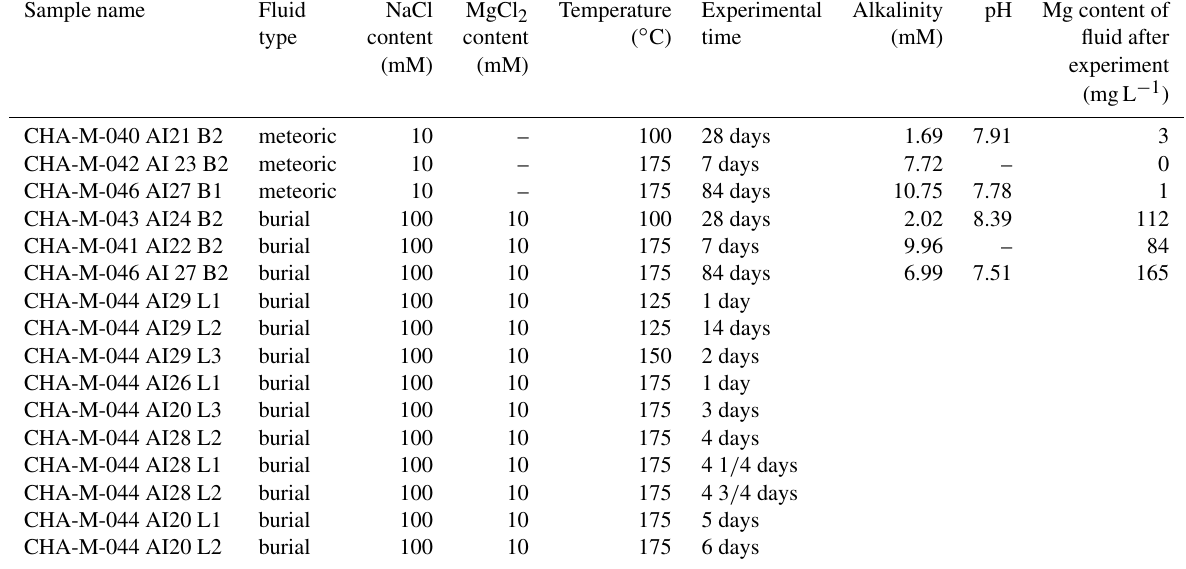
Table 1. Detailed conditions used in hydrothermal alteration experiments of modern Arctica islandica . Major and minor element chemical data of pristine Arctica islandica aragonite and the calcite obtained after treatment are given in Table A1.